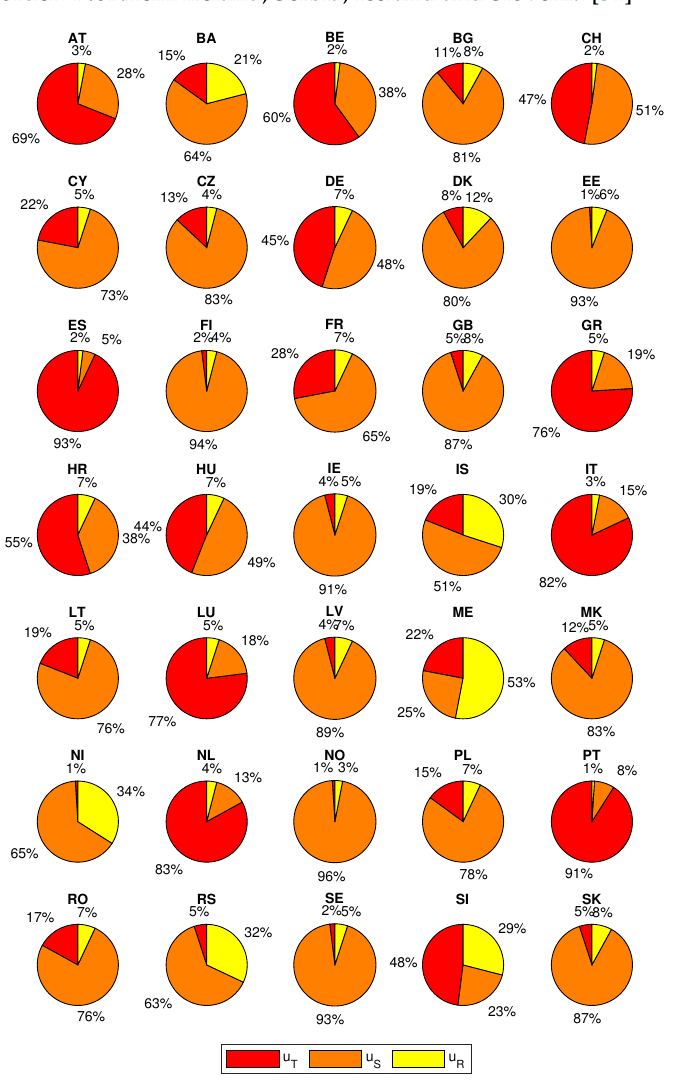
Figure 8. Shares of individual components decomposition in the total variance of the MEL time